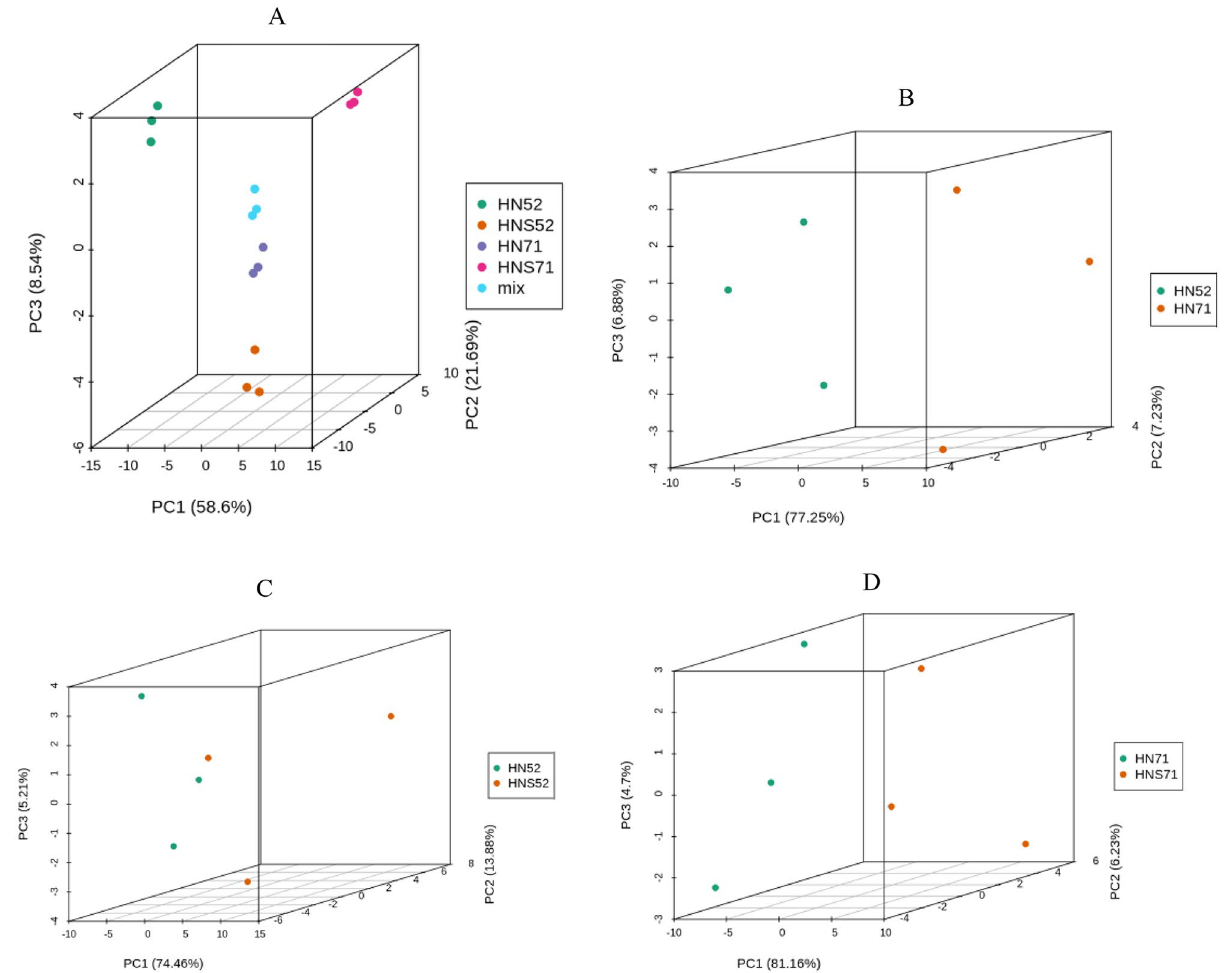
Figure 1. PCA score chart of mass spectrum data of each group of samples and quality control samples. Mix: quality control samples, ( A ): all samples of PCA. ( B ): Two soybean seeds of PCA; ( C ):Soybean and sprouts of PCA(HN52 and HNS52); ( D ): Soybean and sprouts of PCA(HN71 and greater than 50%. These results indicated that the grouping of samples is reasonable. Through PCA of samples (including quality control samples MIX), in order to have a preliminary understanding of the overall metabolic differences between samples in each group and the degree of variability between samples within the group. The PCA results show the trend of metabolome separation between groups, suggesting whether there is a difference in metabolome between sample groups. The X axis represents the first principal component, and the Y axis rep- resents the second principal component. Grouping principal component analysis: before doing difference analy- sis, first perform principal component analysis on the grouped samples for difference comparison to observe the degree of variability between the difference groups and the samples within the group. Differential metabolic analysis of flavonoids. From Table 1, a total of 114 flavonoid metabo- lites were detected in the two soybean varieties and their sprouts. These consisted of 41 isoflavones, 26 fla- vonoids, 14 flavonols, 10chalcones, 6 dihydroflavones, 5 tannins, 4 dihydroflavonols, 3 carbonosides,